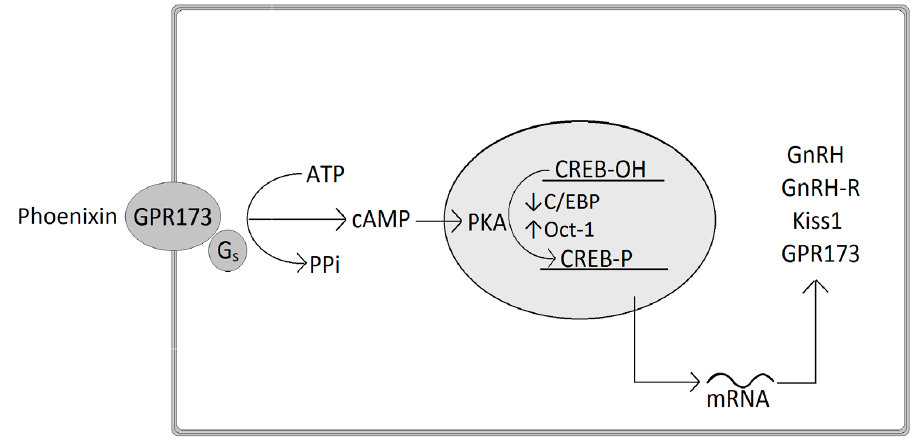
Figure 1. Phoenixin-20 stimulates the mRNA expression of GnRH, GnRH receptor, Kiss1 peptide, and GRP173 via the cAMP-PKA pathway and CREB phosphorylation mediated by the GPR173. Abbreviations: ATP, adenosine triphosphate; cAMP, cyclic adenosine monophosphate; C/EBP, CCAAT/enhancer-binding protein; CREB, cAMP response element binding protein; GnRH, gonadotropin-releasing hormone; GnRH-R, gonadotropin-releasing hormone receptor; GRP173, G protein-coupled receptor 173; Oct-1, octamer transcription factor-1; PKA, protein kinase A; PPi, Pyrophosphate.